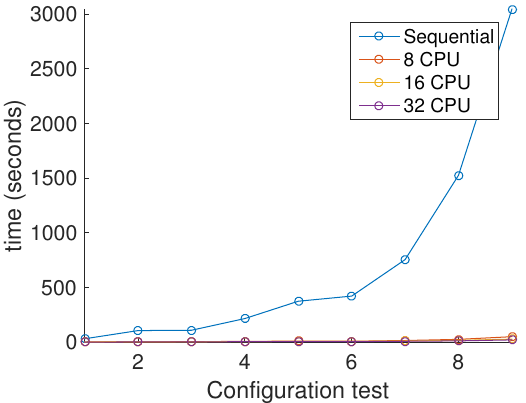
Figure 10. Comparative performance between sequential version and parallel versions.